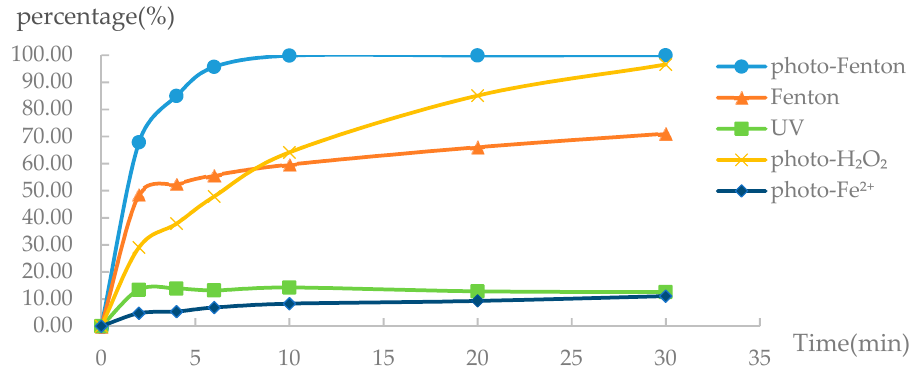
Figure 2. The degradation of trimethoprim under different conditions.